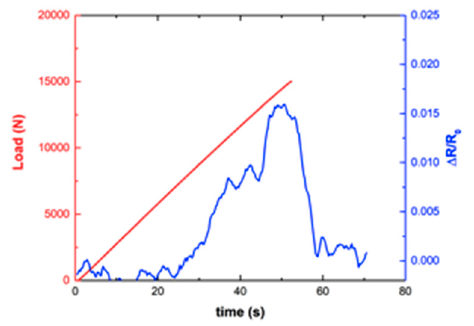
Figure 8. Electrical response as a function of the mechanical load for Channel 6.